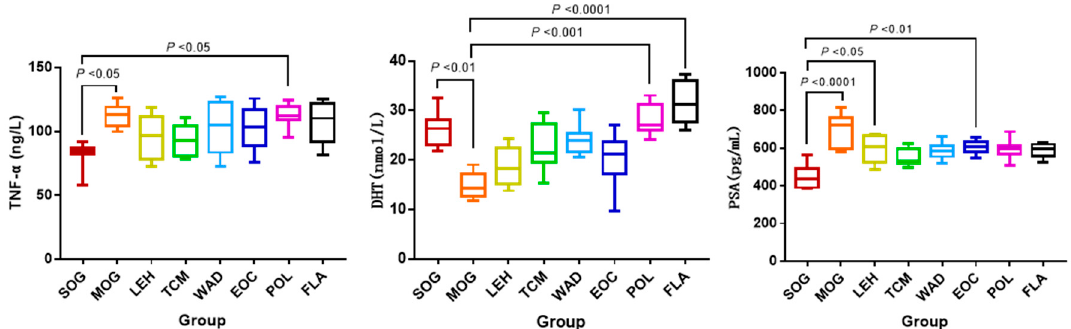
Figure 1. The concentrations of tumor necrosis factor- α (TNF- α ), dihydrotestosterone (DHT) and prostate-specific antigen (PSA). Notes: Sham-operated group (SOG), Chronic nonbacterial prostatitis model group (MOG), Water decoction treatment group (WAD), Essential oil treatment group (EOC), Polysaccharide treatment group (POL), Flavonoids treatment group (FLA), Pule’an tablet treatment group (TCM), Levofloxacin treatment group